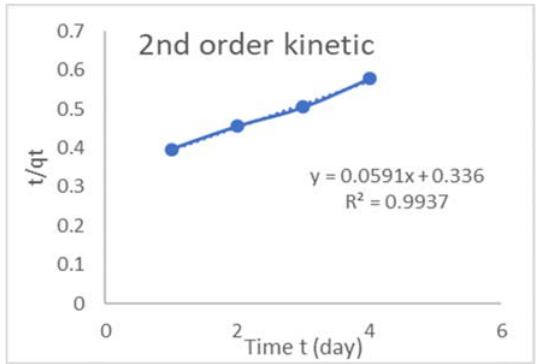
Fig. 12 Pseudo Second order plot of IC Adsorption by corn leaves